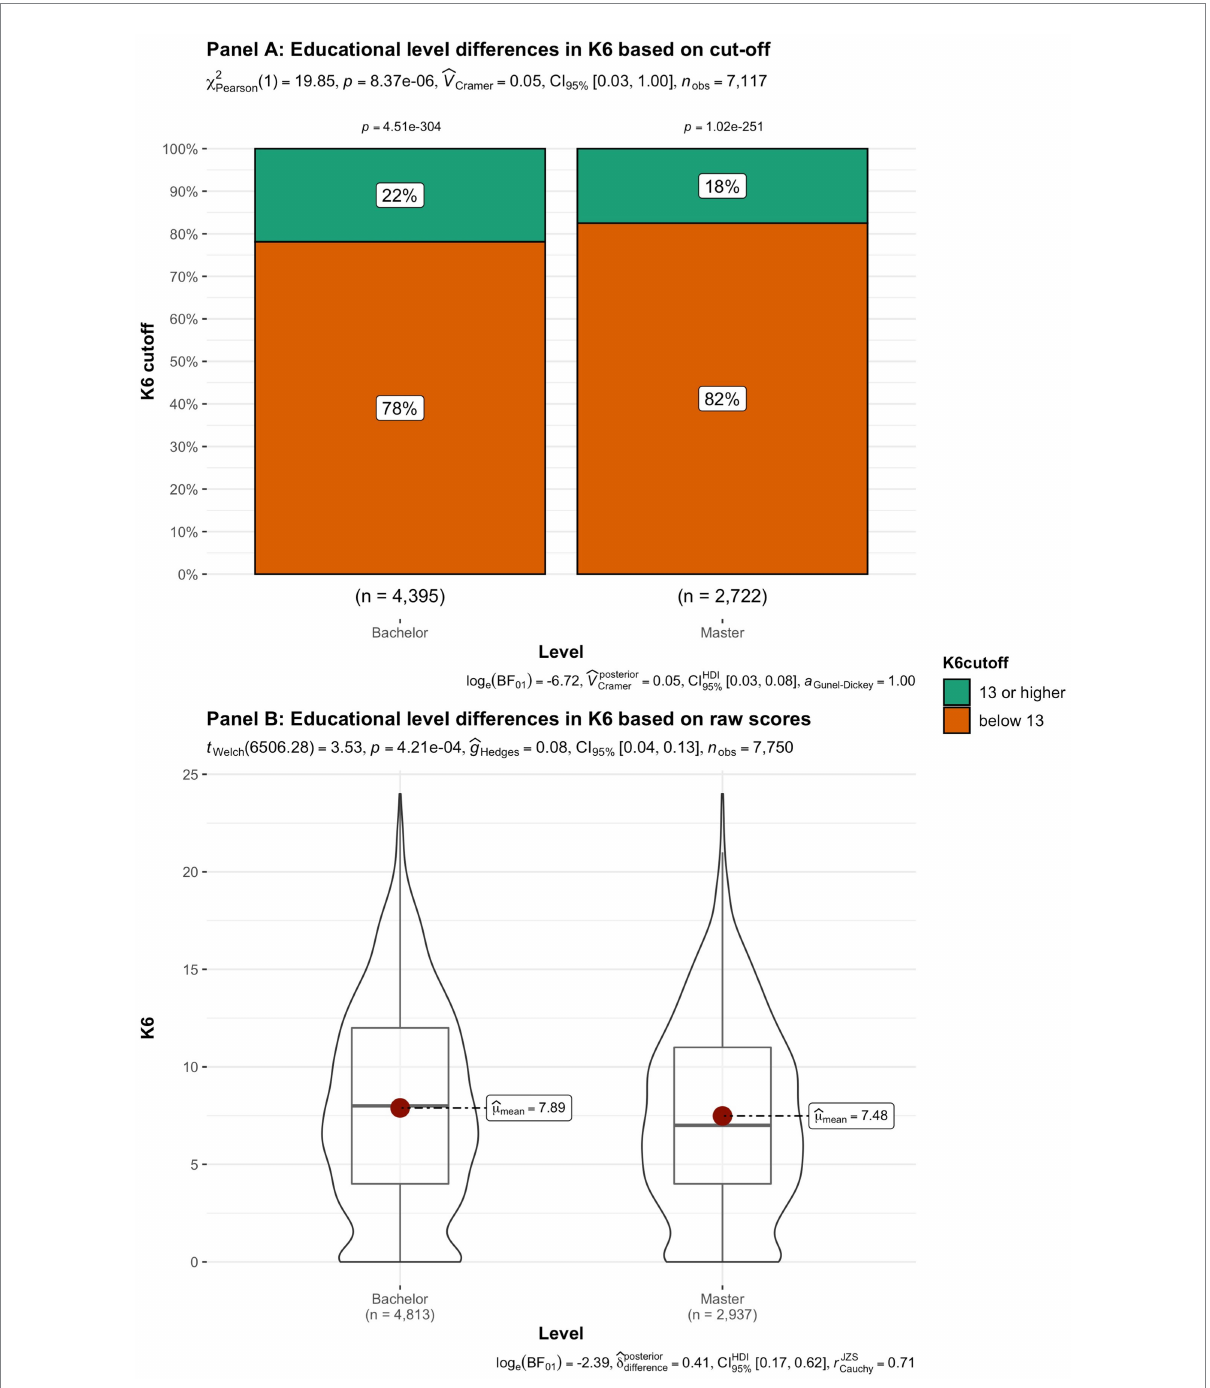
FIGURE 11 Summated scores on the K6 (indicator of mental illness and considered as a cutoff variable) across student subgroups in terms of educational